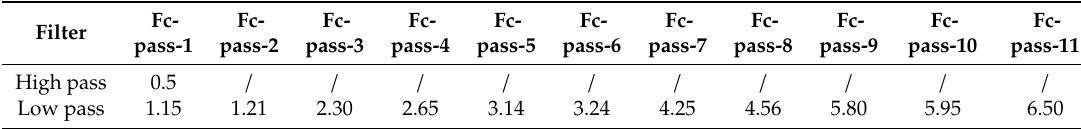
Table 1. Hyper low-pass filtering setup (in Hz).